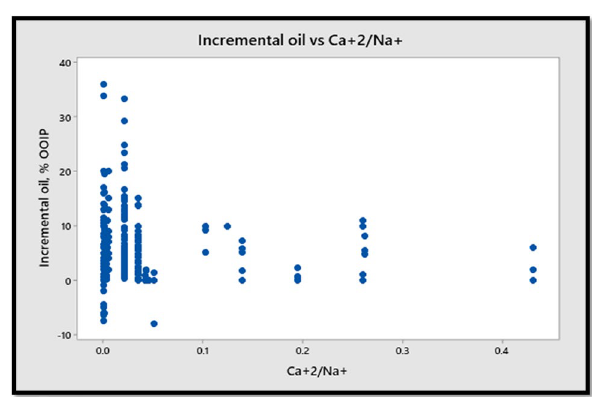
Fig. 6 Relation between Ca +2 /Na + and additional oil